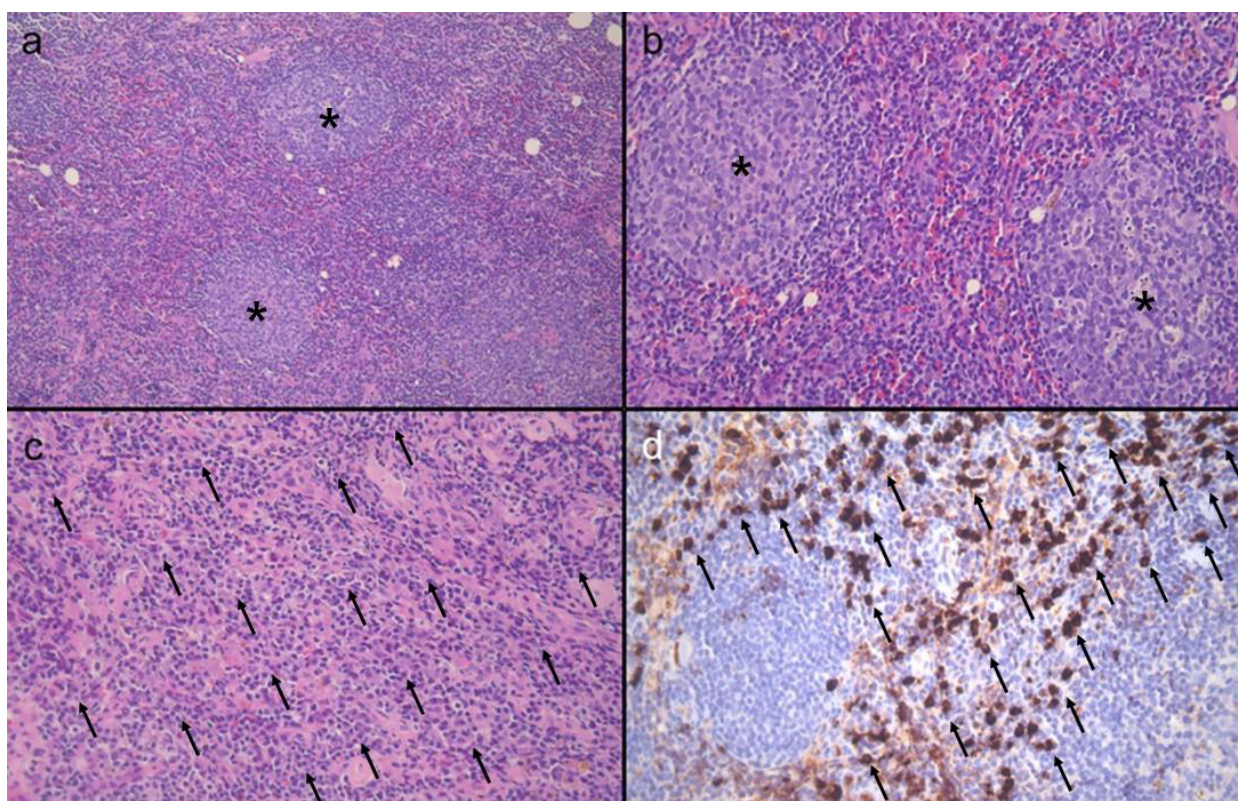
Figure 3. Histologic findings of IgG4-related disease of the lymph node. ( a ) At a low-power image, the lymph node shows follicular hyperplasia accompanying expansion of germinal centers (asterisks). ( b , c ) At high-power images, the inter-follicular area between ( b ) secondary lymphoid follicles (asterisks) and ( c ) the paracortex is rich in plasma cells (arrows). ( d ) Immunohistochemically, there are many IgG4-positive plasma cells (arrows). Original magnification: ( a ) ×200 ( b – d ) ×400.